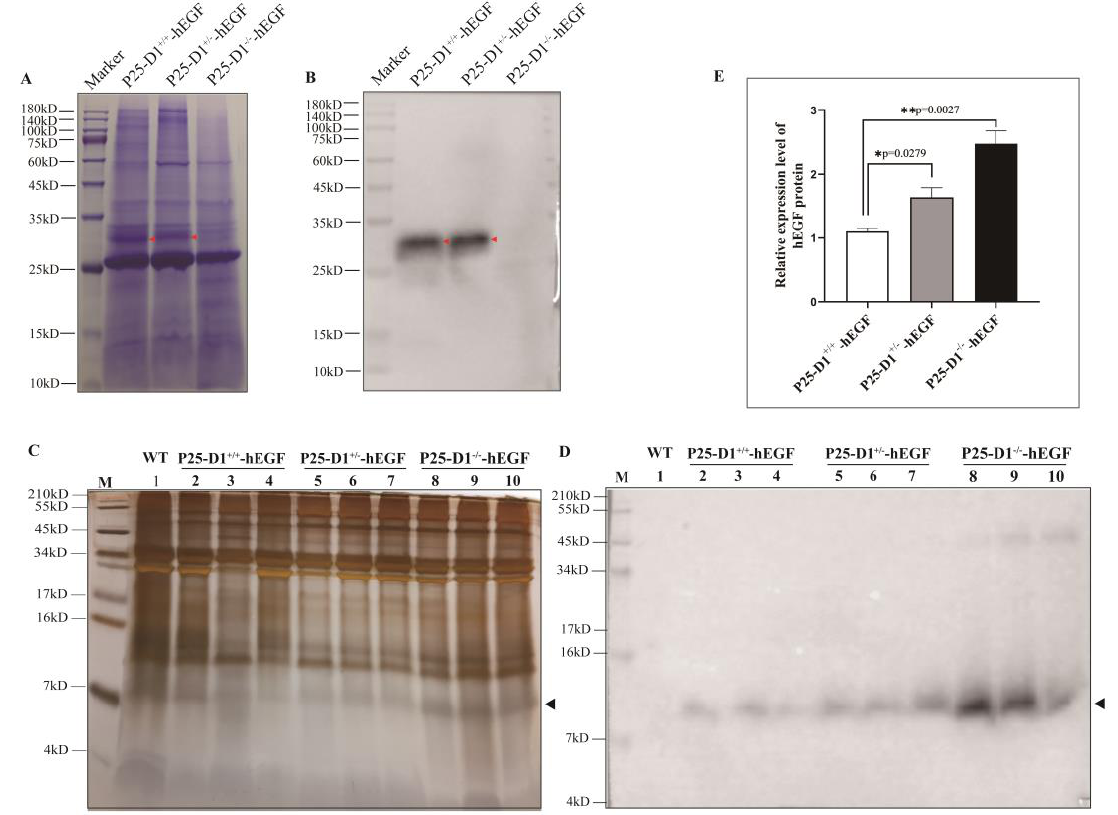
Figure 6. Analysis of hEGF protein expression in hEGF transgenic cocoons in a P25 gene knockout background. ( A , B ) SDS-PAGE ( A ) and Western blotting ( B ) analysis of P25 protein using 15% gradient SDS-PAGE gels. Marker: protein marker and P25-D1 +/+ -hEGF, P25-D1 +/ − -hEGF, and P25-D1 − / − -hEGF, protein samples from the transgenic P25-D1 +/+ -hEGF, P25-D1 +/ − -hEGF, and P25-D1 − / − -hEGF groups. The red arrowhead points to the P25 protein. ( C , D ) SDS-PAGE ( C ) and Western blotting ( D ) analysis of hEGF protein using 15.5% gradient Tricine-SDS-PAGE gels (Sangon, Shanghai, China). M: protein marker; WT: protein sample from non-transgenic wild-type cocoons; 2–4, 5–7, and 8–10, protein samples in triplicate from the P25-D1 +/+ -hEGF, P25-D1 +/ − -hEGF, and P25-D1 − / − -hEGF groups, respectively. The black arrowhead points to the hEGF protein. ( E ) Quantitation of hEGF protein bands by using ImageJ software. P25-D1 − / − -hEGF and P25-D1 − / − -hEGF produced about 2.2- and 1.5-fold more hEGF, respectively, than P25-D1 +/+ -hEGF (* p < 0.05 and ** p < 0.01; n = 3).